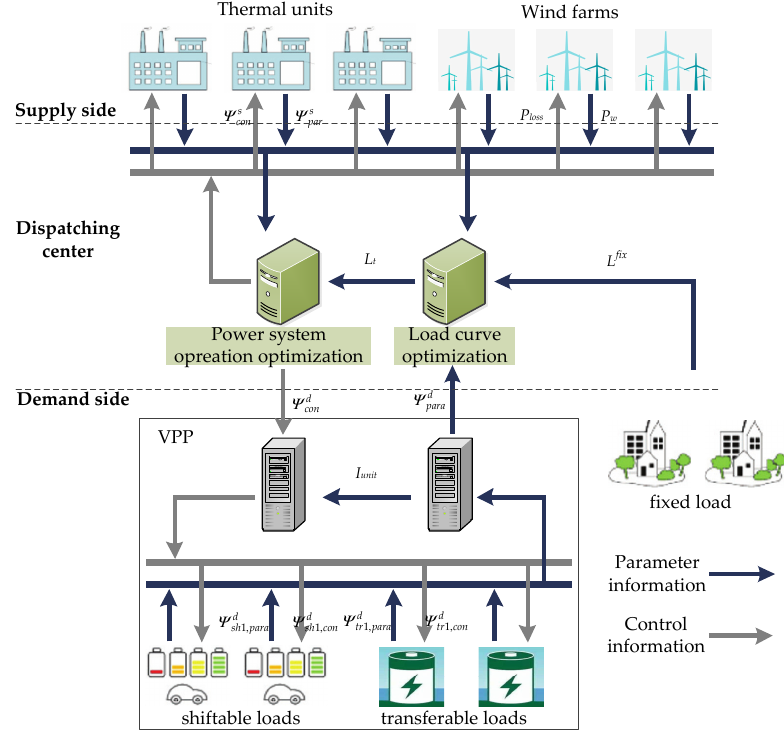
Figure 5. The scheduling structure considering VPP.